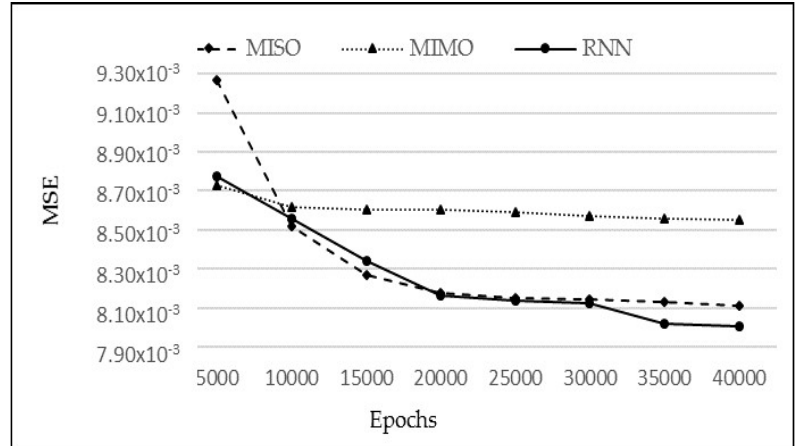
Figure 14. MSE vs. Epochs for MISO, MIMO, and RNN.